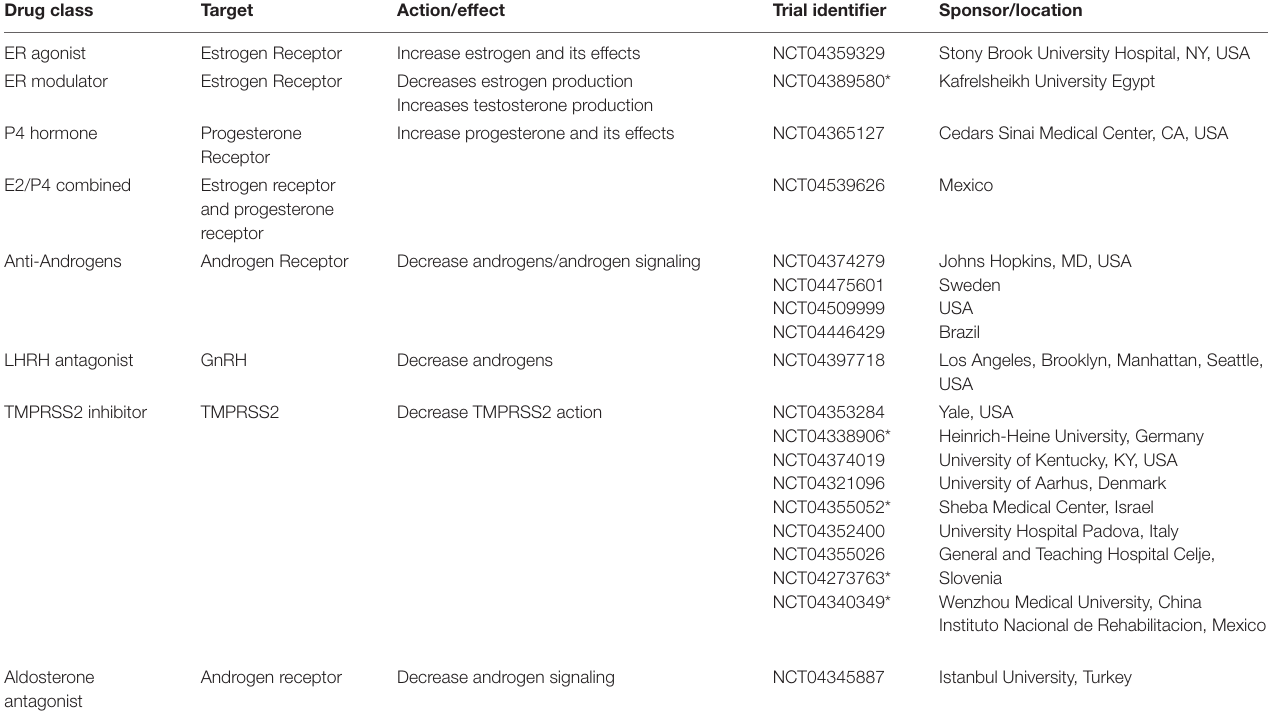
TABLE 1 | Clinical trial identifiers, drug class and